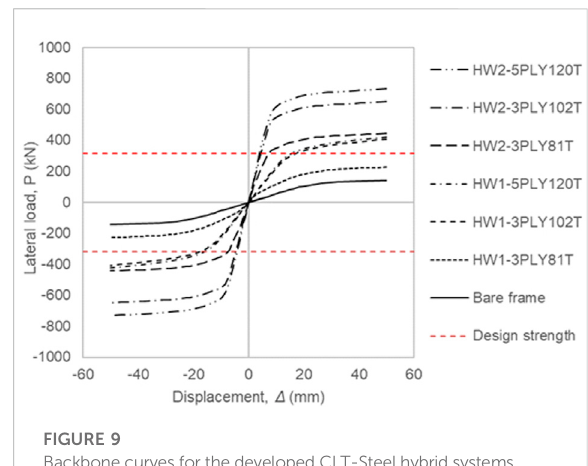
FIGURE 9 Backbone curves for the developed CLT-Steel hybrid